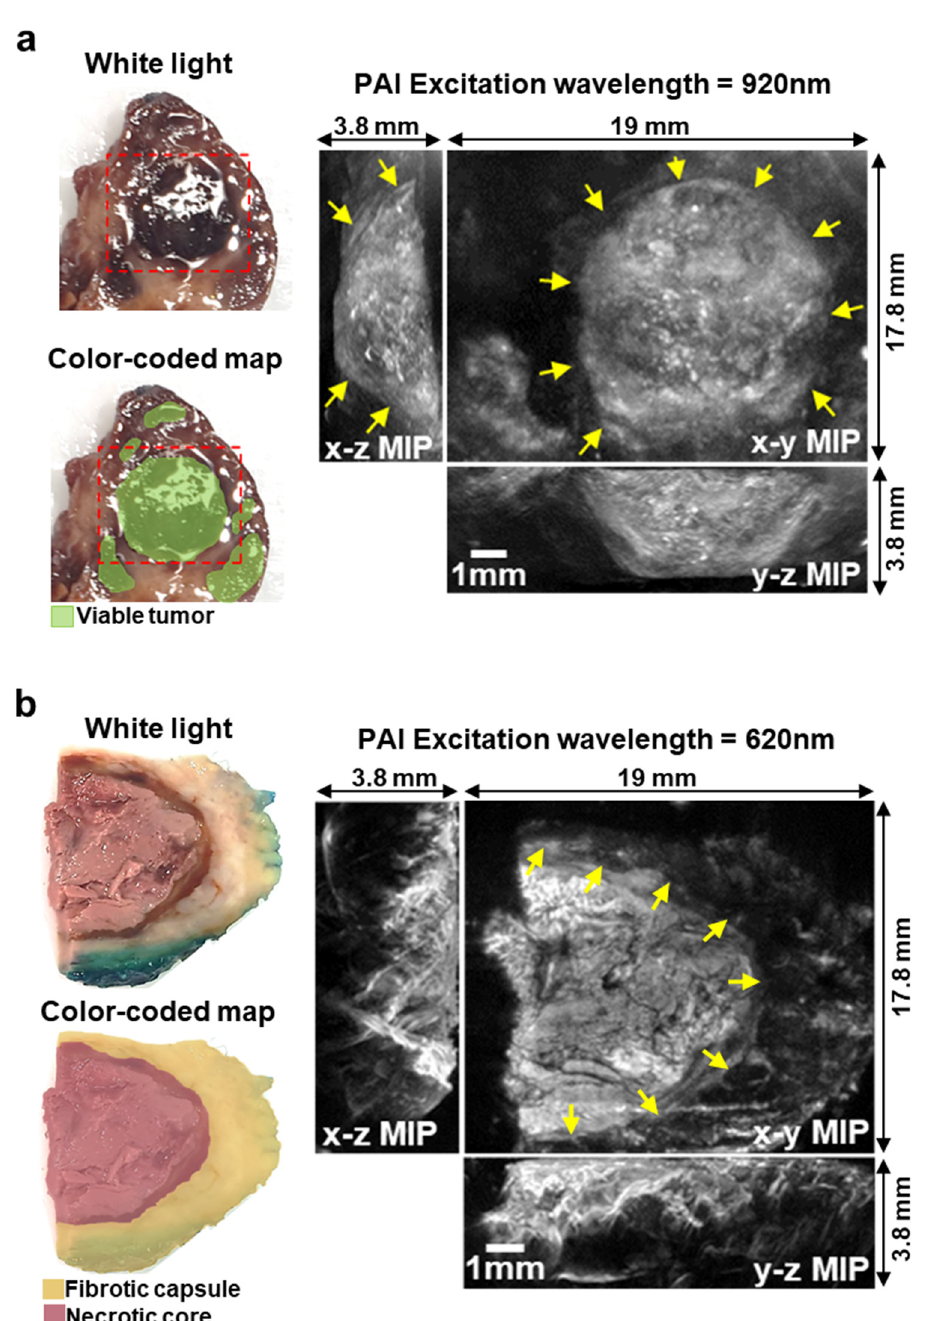
Figure 4. ( a ) White light image and color-coded map of a formalin-fixed surgical section of High-Risk NB after induction chemotherapy. Dashed red line shows the imaged area. On the right, PAI images of the sample (excitation wavelength = 920 nm). The 3D image is shown as maximum intensity projection (MIP). Arrows show the boundary of viable tumor within the PA image. ( b ) White light image and color-coded map of a formalin-fixed surgical section of High-Risk Neuroblastoma after induction chemotherapy. Tumor margins were inked in green for clinical assessment from the histopathology department. On the right, PAI images of the sample (excitation wavelength = 620 nm). The 3D image is shown as MIP. Arrows show the boundary of the fibrotic capsule surrounding the necrotic core of the